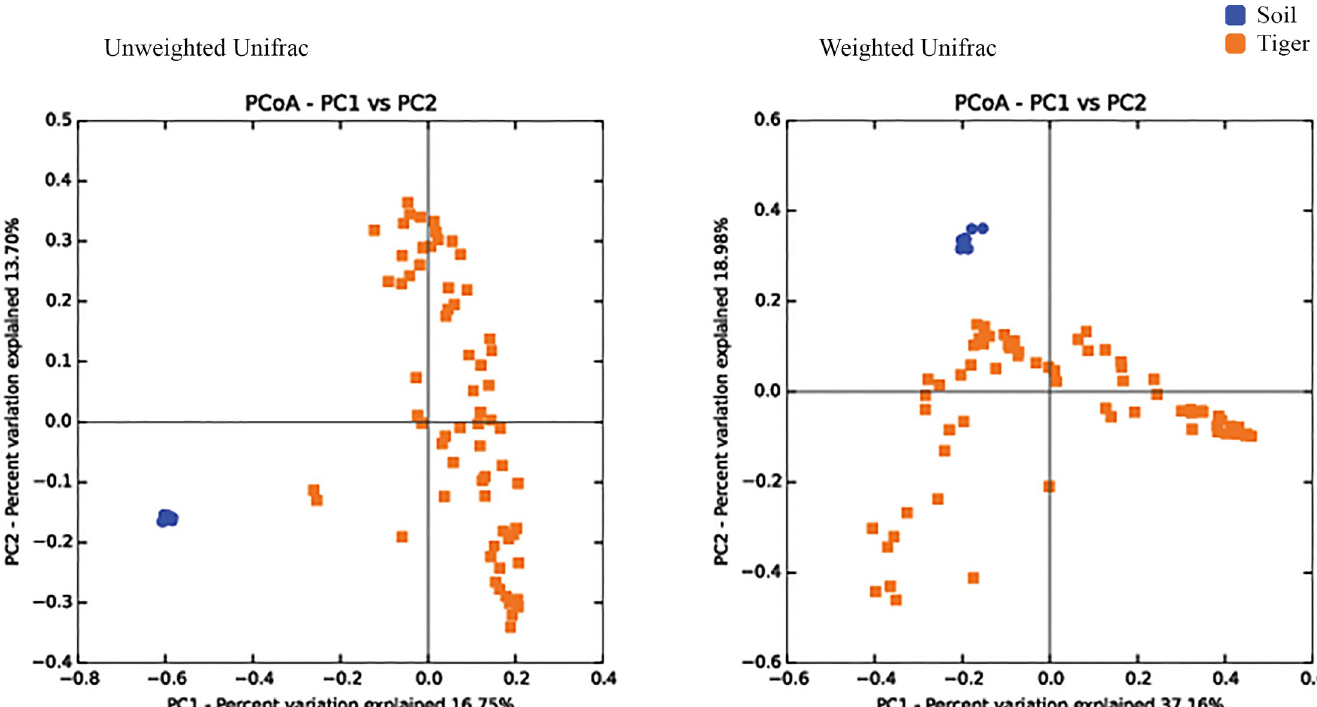
Fig 2. Principal Coordinate Analysis (PCoA) of soil (all sites, n = 8; CNP, n = 3; BNP, n = 5) and tiger fecal samples (all sites, n = 32; CNP, n = 12; BNP, n = 12; SWR, n = 8). Gut microbiota profiles for soil samples are distinct from fecal samples indicating that cross-contamination between these two sample sources is unlikely.